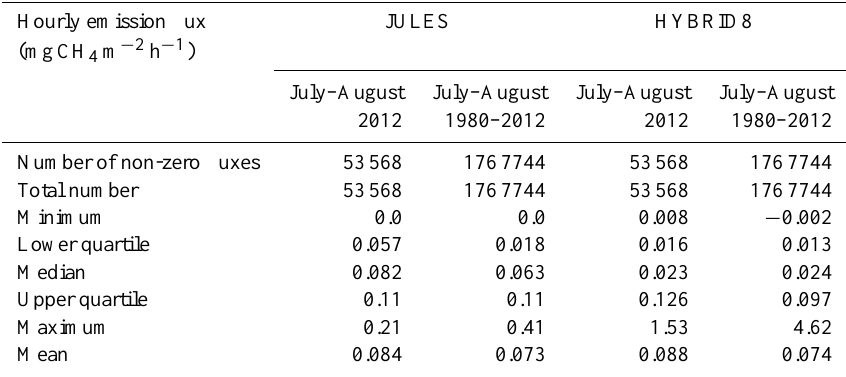
Table 3. Distribution of the modelled hourly wetland methane emission fluxes (mgCH 4 m − 2 h − 1 ) for the domain (20.0–29.0 ◦ E, 67.5– 68.5 ◦ N) for two periods: July–August 2012 and the July–August climatology between 1980 and